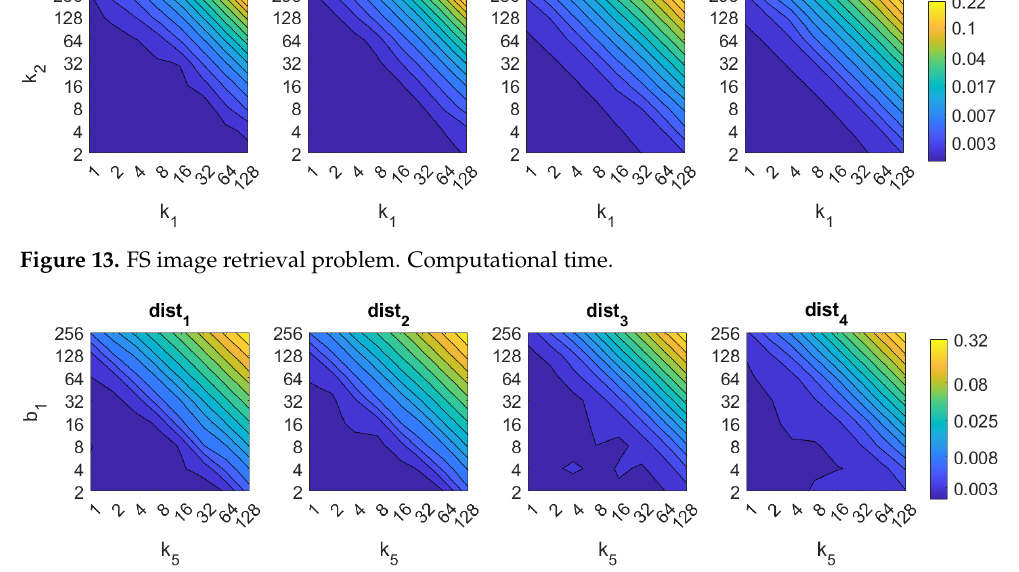
Figure 14. HOG image retrieval problem. Computational time.